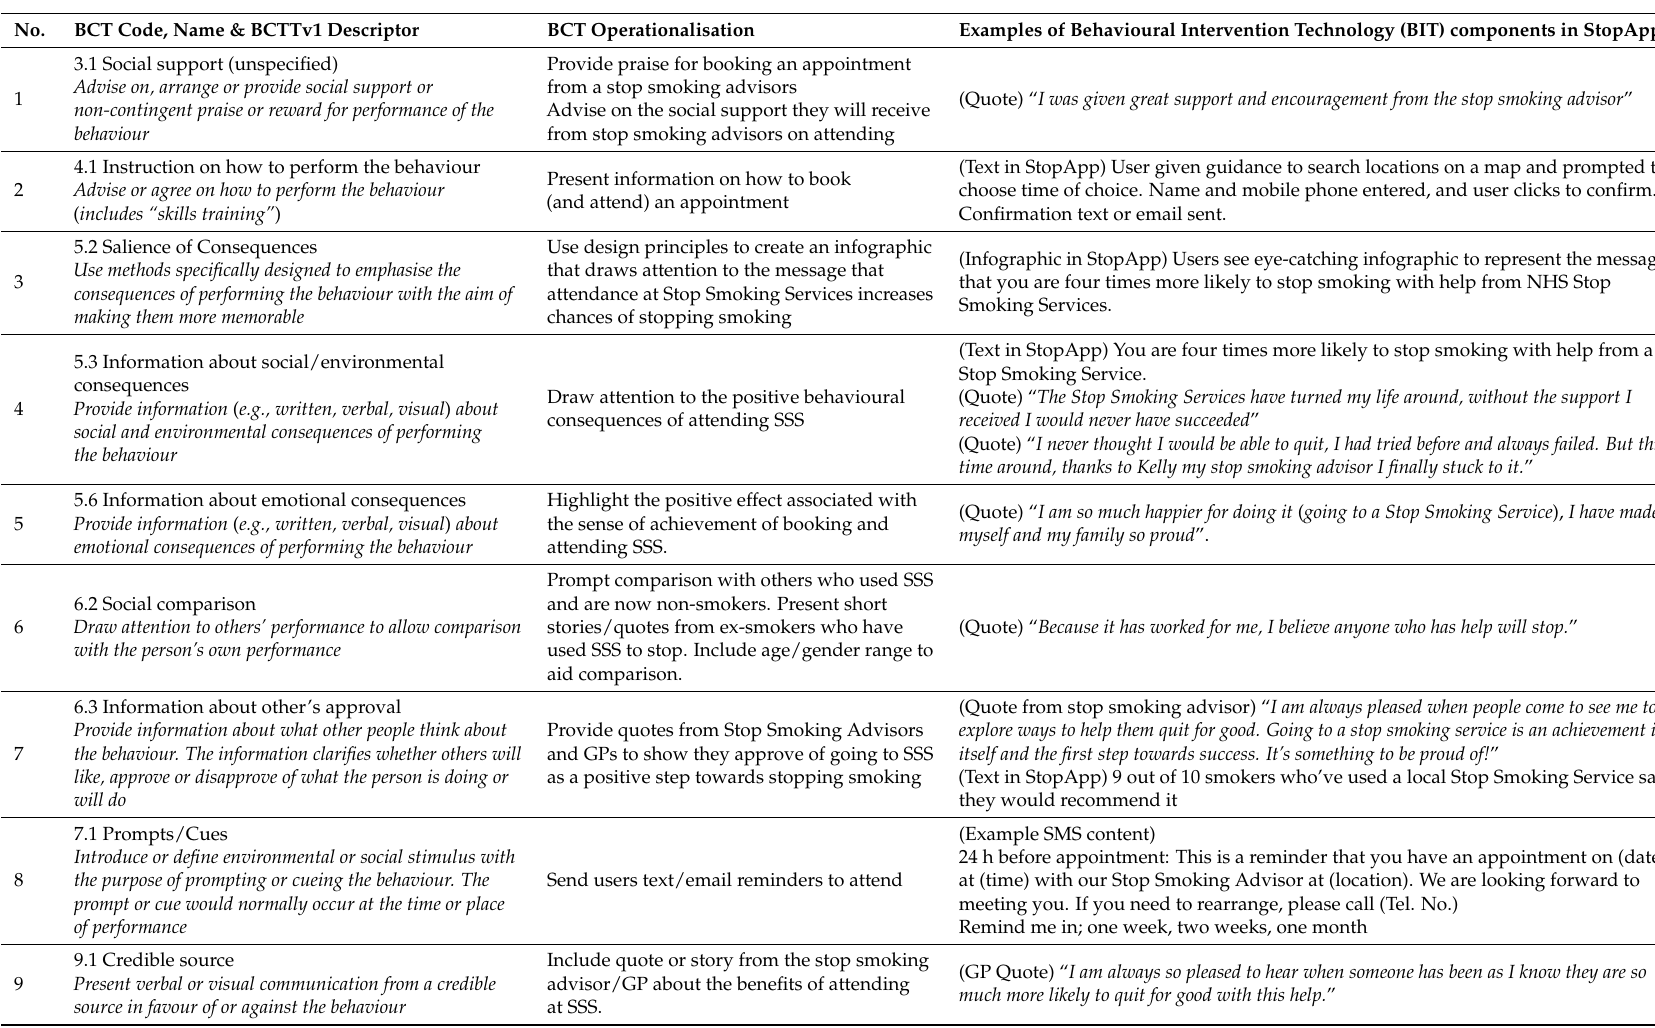
Table 1. Behaviour change technique (BCT) representation in digital format for